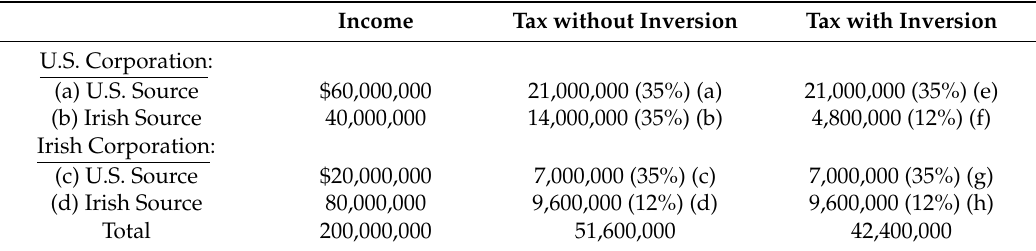
Table 1. Tax without and with